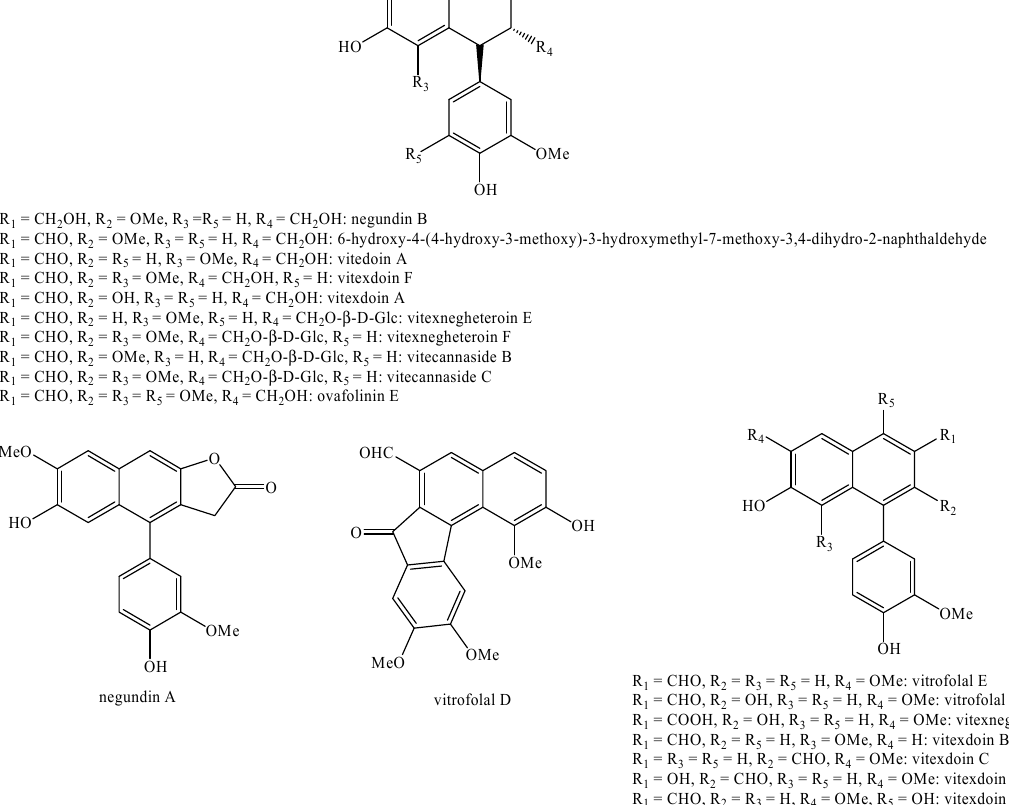
Figure 20. Isolated nor -lignans in the plant kingdom—part 19.